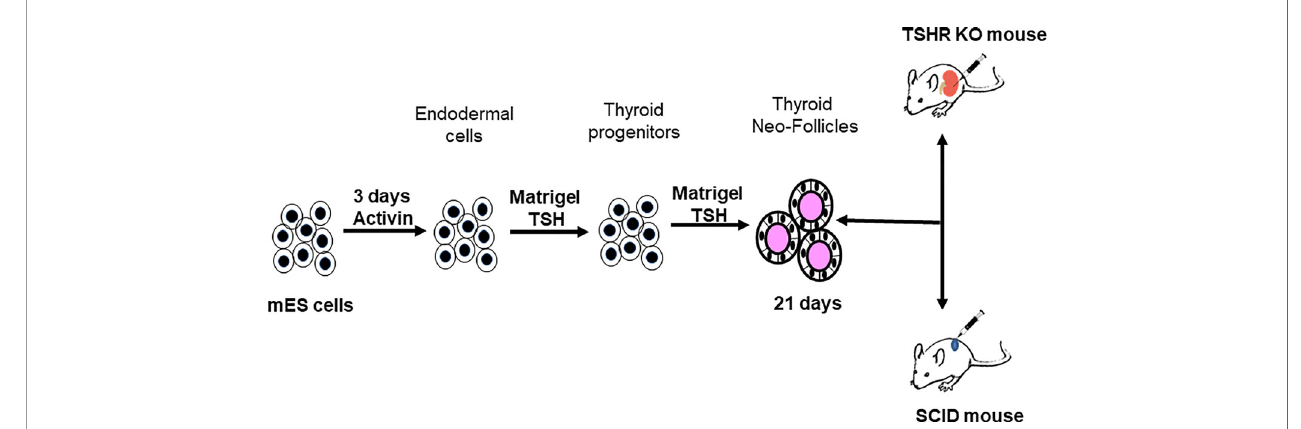
FIGURE 4 | Protocol for thyroid cell differentiation. Stable mES+/- cells transfected with Pax8 and Nkx2-1 with and without tagged reporter constructs were fi rst differentiated to form anterior endodermal cells by activin A treatment. These cells were then embedded in a Matrigel scaffold and treated for 21 days with TSH to differentiate into thyroid follicular cells (TFCs). The differentiated cells were recovered from the scaffold, washed, counted and resuspended in medium prior to injecting them either into SCID mice or TSHR-KO mice as detailed in Figure 5